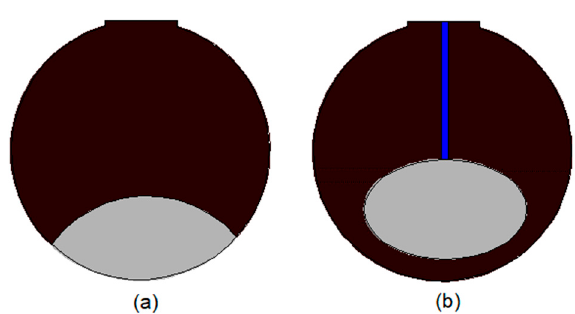
Figure 7. Melting of the PCM inside a sphere, adapted from Tan [58]: ( a ) close contact melting and ( b ) fixed solid.